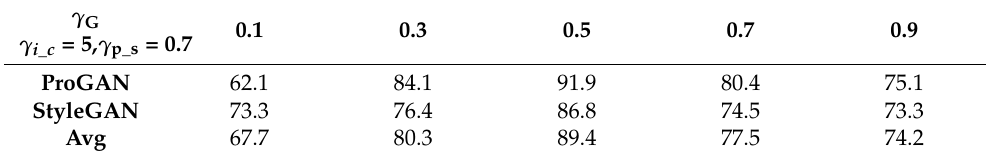
Table 3. Hyper-parameter analysis in global detection (Test criteria adopt accuracy